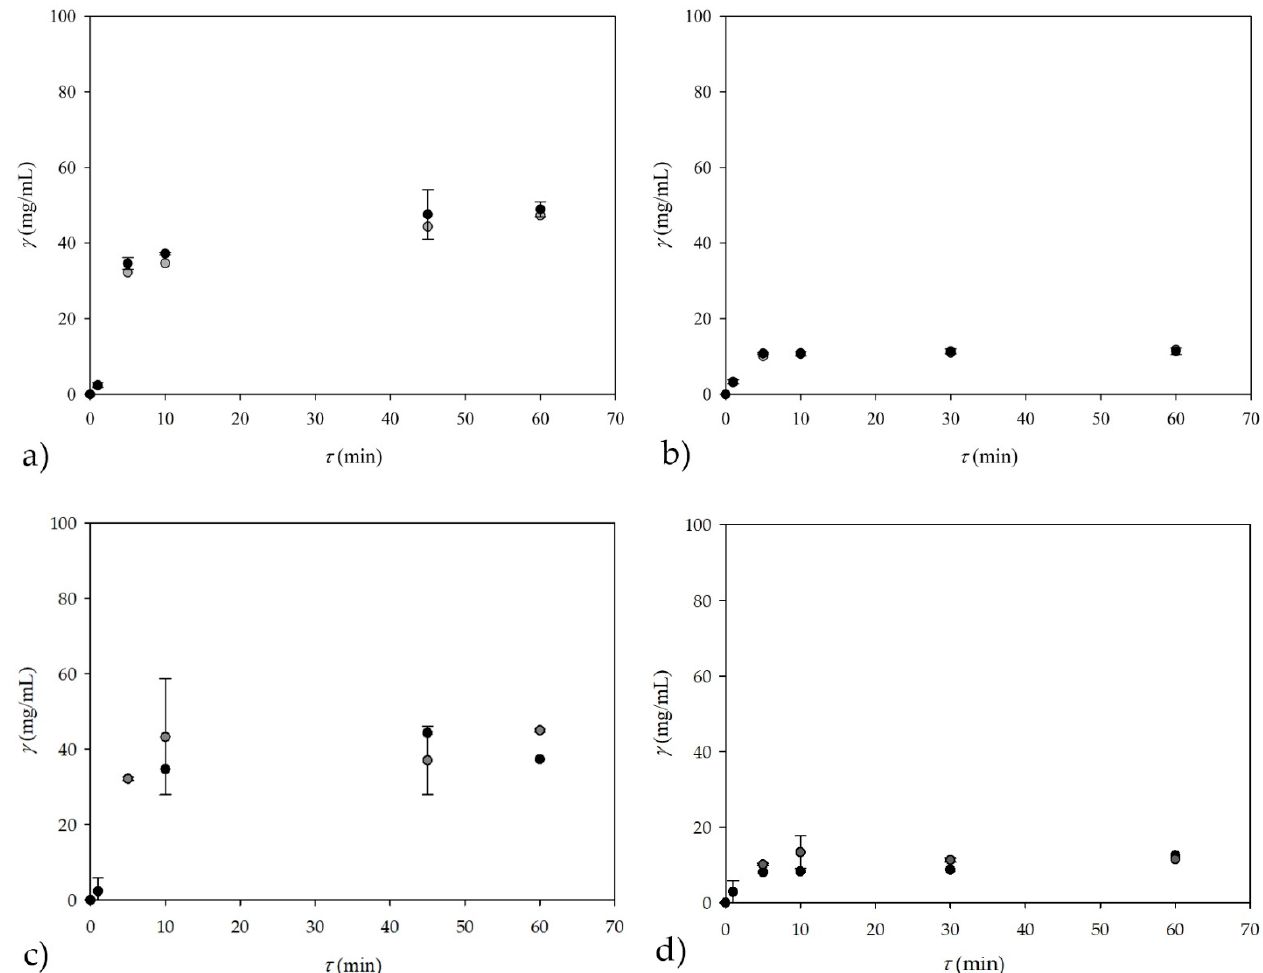
Figure 8. On-line measurement of glycerol concentration by NIR spectroscopy during the transesterification reaction carried out in a T-shaped microreactor. ( a ) Experiment with the high surplus of methanol (oil to methanol molar ratio = 1:93); ( b ) experiment with a stoichiometric oil to methanol ratio (oil to methanol molar ratio = 1:3.4); ( c ) experiment with the high surplus of methanol (oil to methanol molar ratio = 1:93) using subsampling ANN; and ( d ) experiment with a stoichiometric oil to methanol ratio (oil to methanol molar ratio = 1:3.4) using subsampling ANN ( ● — calculated, theoretical glycerol, ● — NIR spectroscopy on-line measurement).